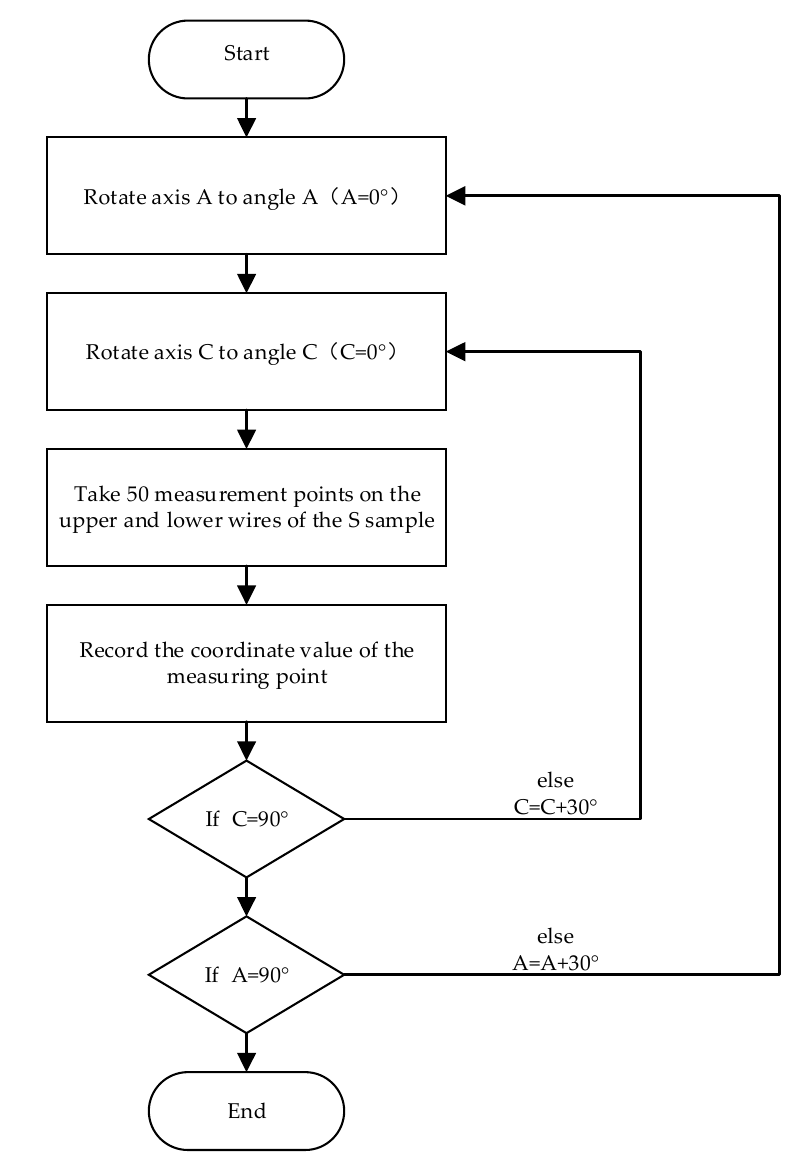
Figure 8. Measurement flow chart. It can be seen from Tables 2 and 3 that the maximum error value of the variable distortions of the S-shaped curve is the largest between the 23rd and 30th measuring points. In the constant curvature part of the curve, the maximum error value is the smallest, as is given in the relevant ISO 10791-7:2020 standards. When the A-axis and C-axis equal 0°, S- the minimum error value. According to Table 3, the maximum error value reaches its peak value in the section of the curve without distortion, and the minimum is in the constant curvature section. At the same time, the minimum error value reaches its maximum in the untwisted part of the curve and its minimum in the constant curvature section. Comprehensive analysis shows that the maximum and minimum error values of S-shaped specimen are larger in the variable curvature, variable distortion, and no distortion sections, and smaller in the constant curvature